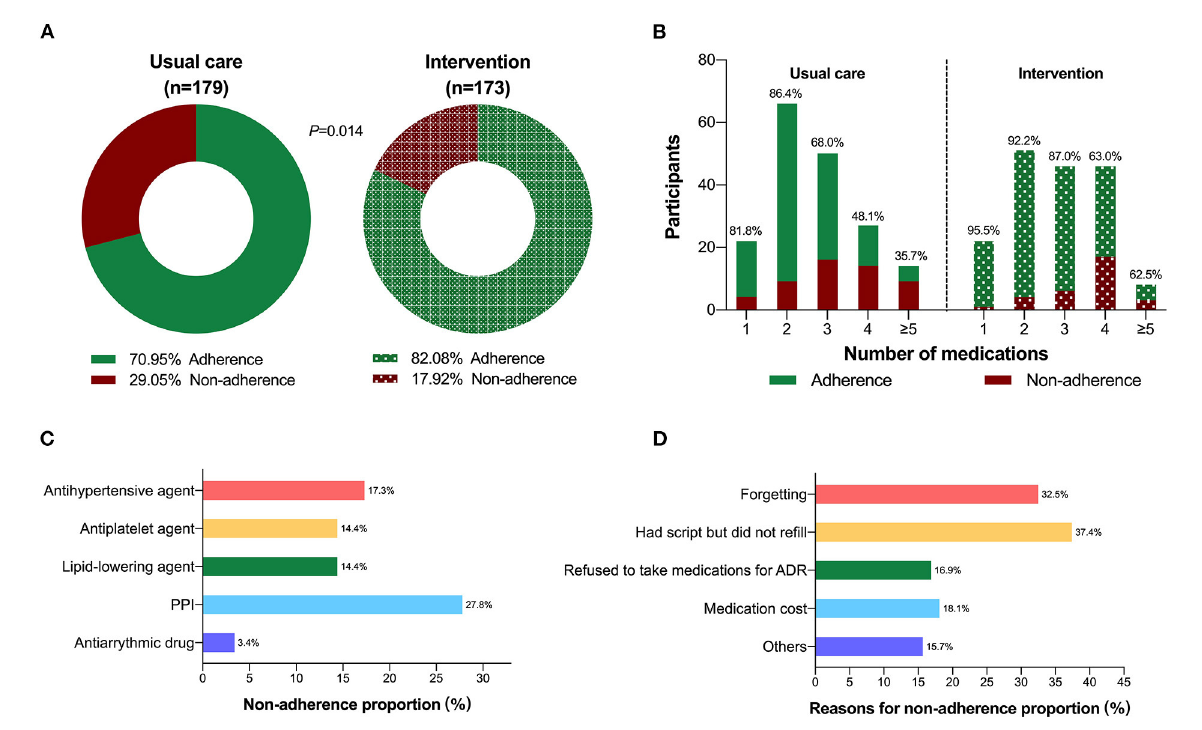
FIGURE3 Rates of total adherence stratified by group. (A) Number of medication prescribed (B) ; (C) Drug nonadherence by different medication classes in all cohort; (D) Reasons for non-adherence among non-adherent patients.